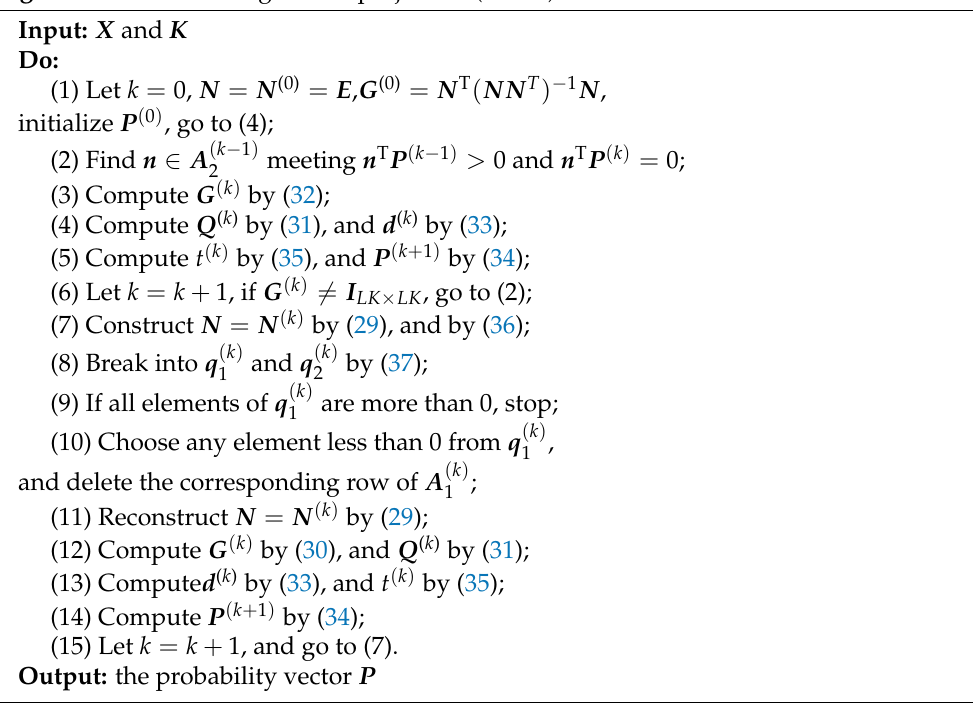
Algorithm 1 Fast active gradient projection